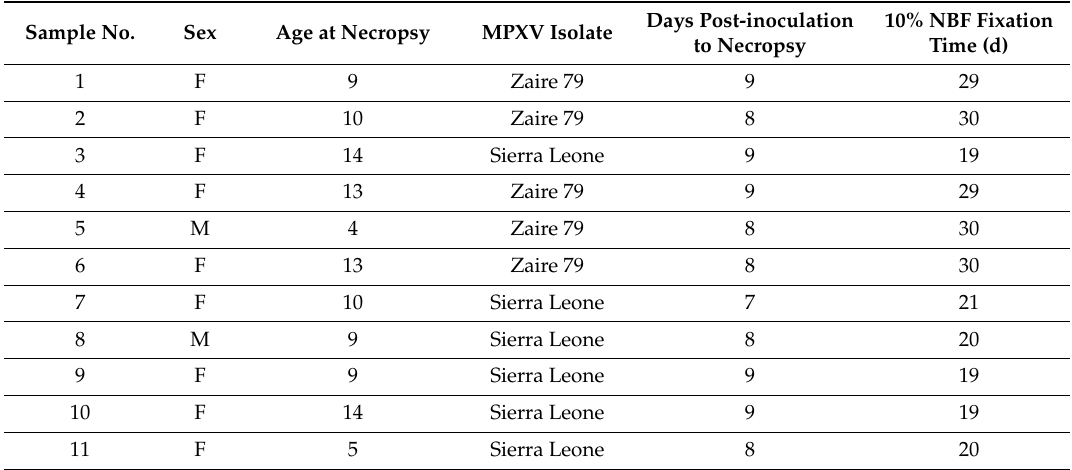
Table 2. Monkeypox virus-positive haired skin sample collection from rhesus monkeys infected at a dose of 5 × 10 6 PFU.